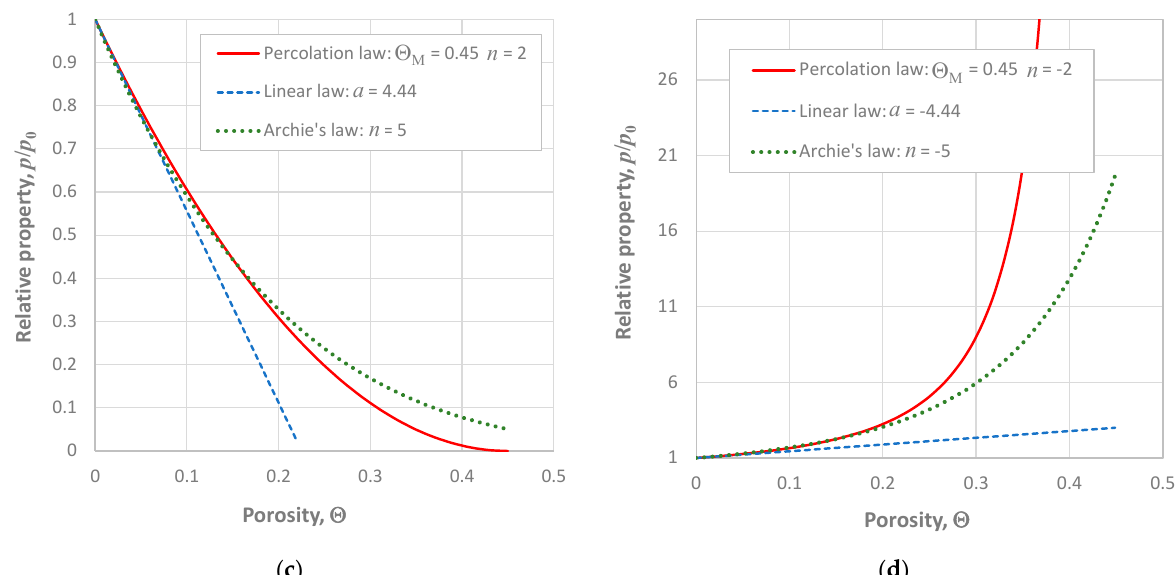
Figure 1. Dependence on the porosity of the normalised property p / p 0 : ( a ) according to Equation (1) for different values of Θ M and positive n ; ( b ) idem with negative n ; ( c ) comparison for the models given by Equations (1)–(3) for positive values of n ; ( d ) idem for negative n .